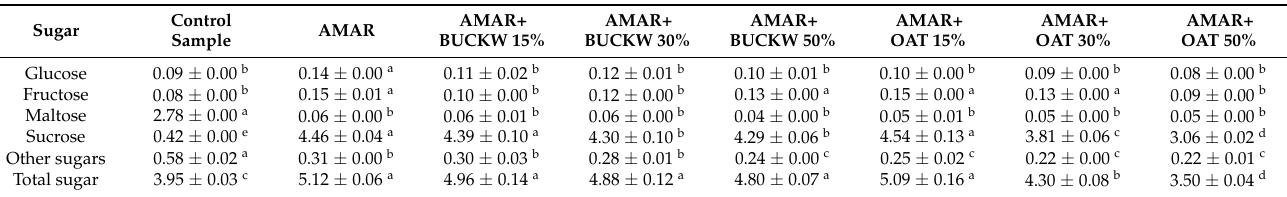
Table 6. Sugar composition of pasta (g 100 g − 1